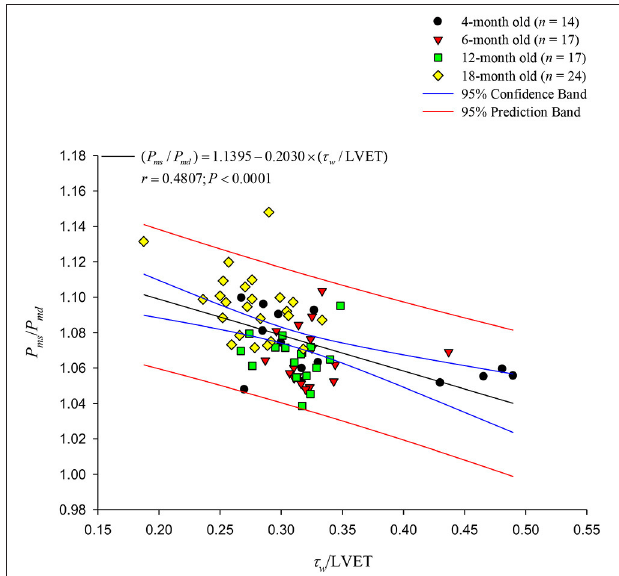
FIGURE 8 | Relationship between the P ms / P md ratio and the τ w /LVET ratio. The aortic P ms / P md ratio was significantly inversely related to the τ w /LVET ratio. LVET, left ventricular ejection time; P md , mean diastolic pressure; P ms , mean systolic pressure; τ w , wave transit time.